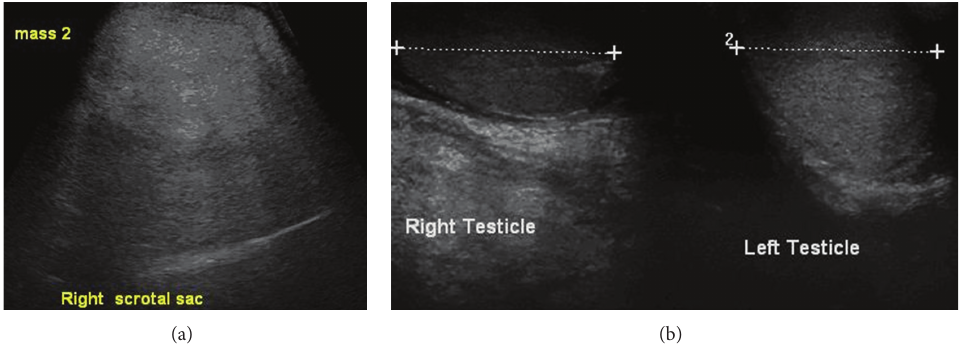
Figure 1: Bilateral normal testes (a) with a hetrogenous mass in the right hemi-scrotum (b).